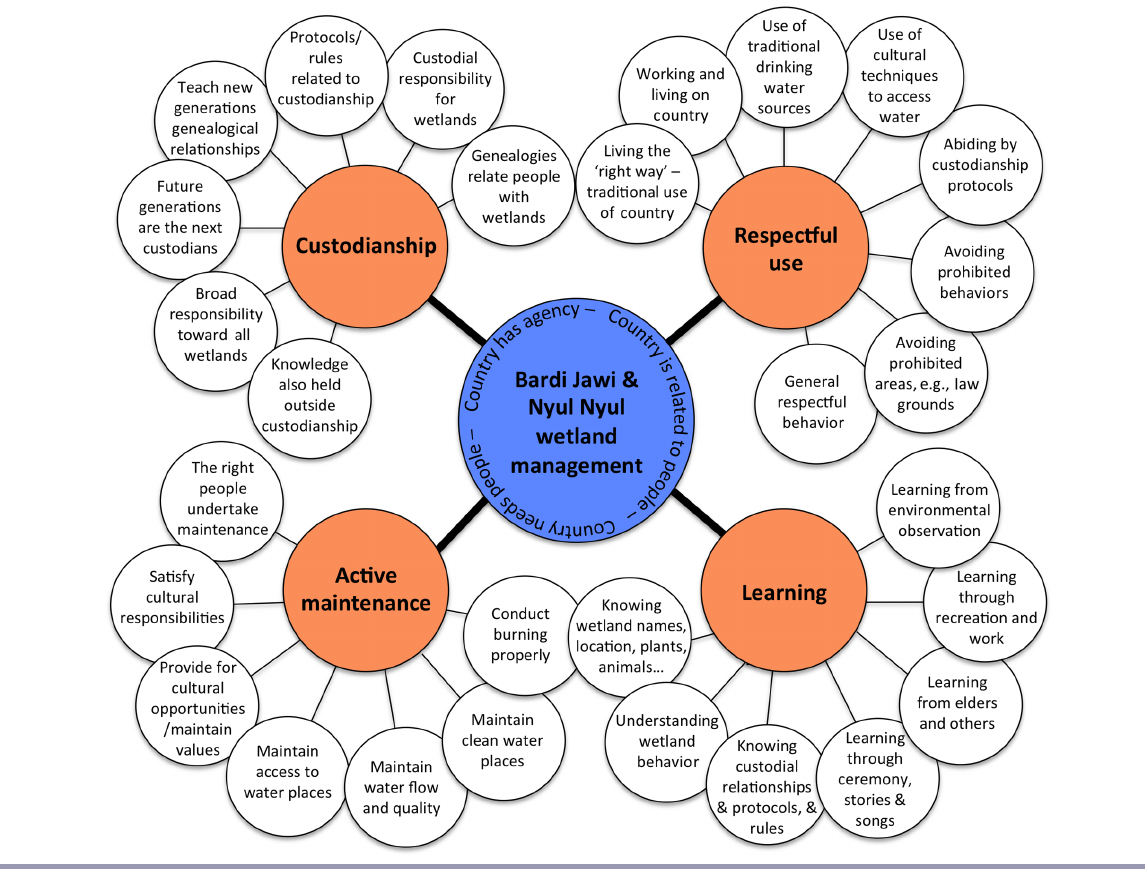
Fig. 2 . Conceptual framework depicting the Bardi Jawi and Nyul Nyul wetland management system, including beliefs (inner blue circle), principles (orange circles), and related elements (small